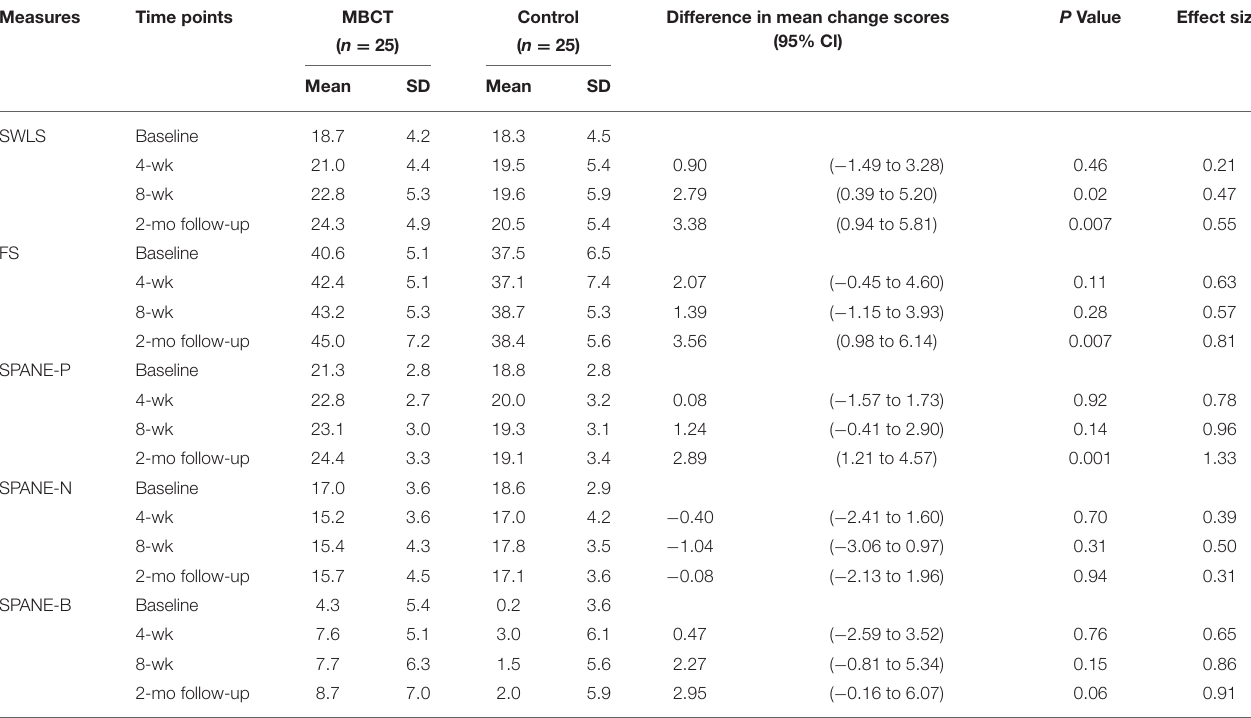
TABLE 6 | Effects of repeated-measure analyses of well-being outcomes (intention-to-treat population).